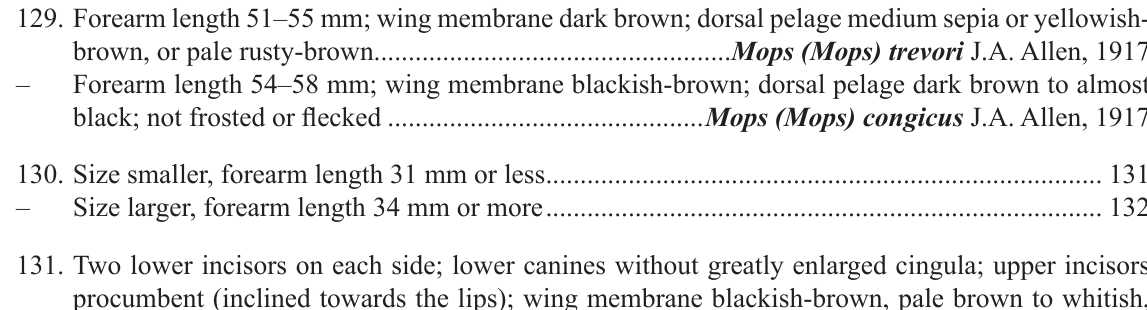
– Ventral flank stripe absent; wing membrane various shades of brown; ventral pelage pale; occipital helmet moderately prominent; wing insertion lower on body; basisphenoid pits moderate or shallow deep and medium to large in size; forearm length 34–41 mm........................................................... .............................................................................. Mops (Xiphonycteris) thersites (Thomas, 1903) 133. Little white on ventral surface; forearm length 60–67 mm; both sides of wing membrane dark brown to almost black; basisphenoid pits medium in size; plantar pad absent ................................. – Clear white, cream or yellowish ventral flank band present; forearm length 56–61 mm; dorsal side of wing membrane brown, ventral side whitish; basisphenoid pits large in size; plantar